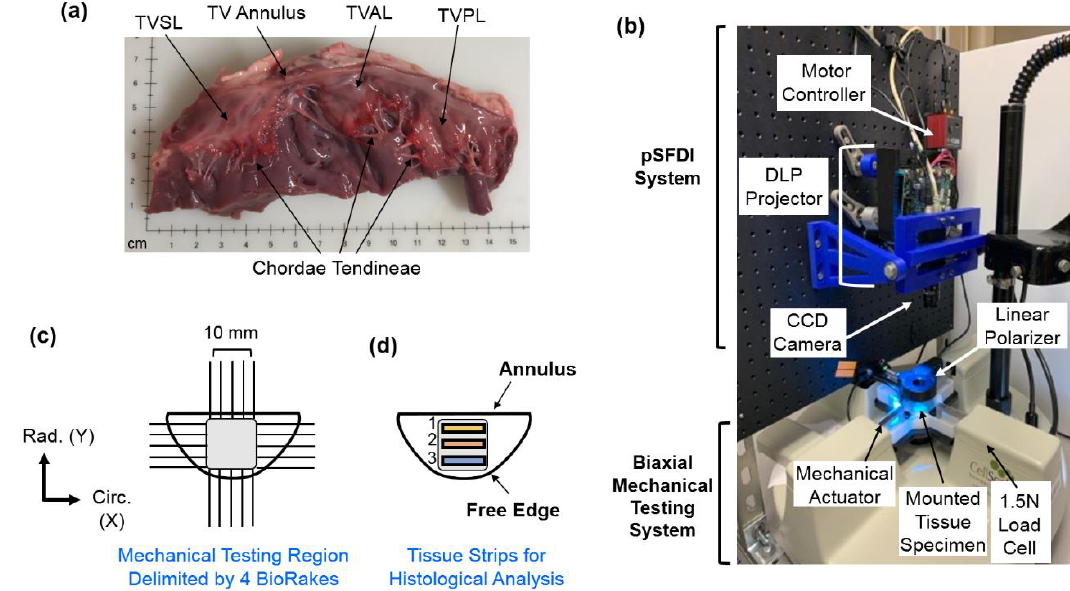
Figure 1. ( a ) The porcine TV was dissected to retrieve the three TV leaflets for use in ( b ) biaxial mechanical testing. ( c ) A side view of the combined pSFDI-biaxial testing system, displaying optical components, mounted tissue specimen, and mechanical testing components. ( d ) TV leaflet strips from the effective testing region were used for histological analyses.